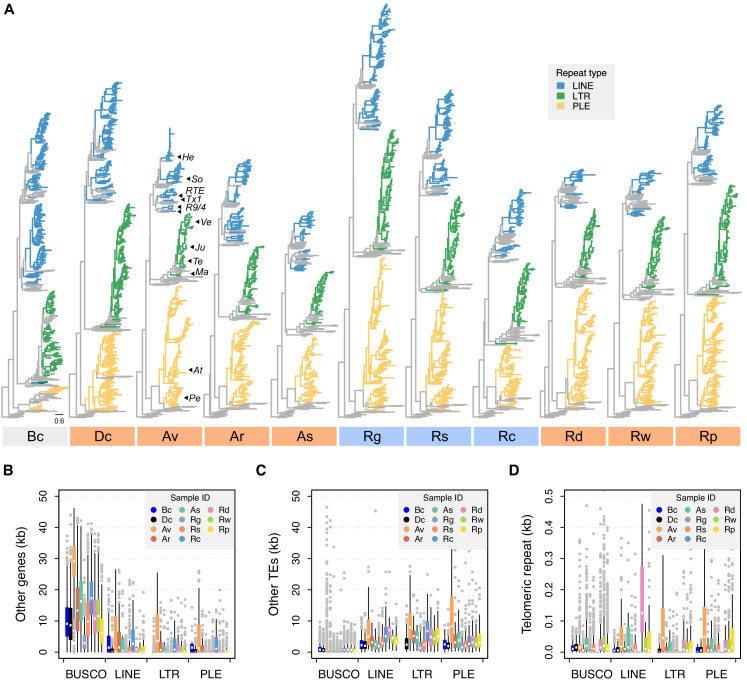
Phylogenetic diversity and genomic context of reverse transcriptase (RT) genes.(A) For each phylogeny, coloured branches represent identified rotifer-encoded RT copies and grey branches represent the core RT sequences from which the hidden Markov model (HMM) was built (see Figure 5—figure supplement 1 for core RT tree details). Colours indicate the major superfamilies. Previously characterized retrotransposons are indicated on the A. vaga tree (He, Hebe; So, Soliton; RTE, RTE; Tx1, Tx1; R9/4, R9 and R4; Ve, Vesta; Ju, Juno; Te, TelKA; Ma, Mag; At, Athena; Pe, Penelope). All phylogenies are rooted on the branch separating the bacterial retrons. Scale bar represents 0.6 amino acid substitutions per site. Desiccating and nondesiccating species are indicated with orange and blue, as previously. Species codes: Bc, B. calyciflorus PSC1; Dc, D. carnosus DCAR706, Av, A. vaga Av2013; Ar, A. ricciae ARIC003; As, A. steineri ASTE805; Rg, R. magnacalcarata MAG3; Rs, R. socialis AK11; Rc, R. macrura Rc2018; Rd, R. sordida RSOR408; Rw, R. sp. ‘Silwood-1’ RSIL806; Rp, R. sp. ‘Silwood-2’ RPSE503. The genomic context in which RT genes reside is then described based on proximity to three other features: (B) other genes (that do not overlap with any TE annotation), (C) other TEs, and (D) telomeric repeats (‘TGTGGG’; that do not overlap with any coding region) as identified in A. vaga. For each plot, a 50 kb window is drawn around the focal TE and the total span (kb) of each feature within the window is counted, broken down per sample ID (coloured boxes, see legend) per TE superfamily (X-axis groups). Boxplots show the median (band), interquartile range (box) and minimum/maximum values (whiskers; outliers are shown in grey). The equivalent data for BUSCO genes (metazoan set) are also shown for comparison. The same set of individuals are shown in (B–D) as for (A). Average values (mean ± SD) across monogononts and bdelloids (desiccating and nondesiccating) are provided in Figure 5—source data 4.Figure 5—source data 1.Reverse-transcriptase alignments and phylogenies.Figure 5—source data 2.Identification of putative telomeric repeats in rotifer genomes.Figure 5—source data 3.Posterior mean and 95% credible intervals for the effects of asexuality and desiccation ability on the density of three features (other genes, other TEs and telomeric repeats) surrounding LINE, LTR, and PLE class I TEs, compared to BUSCO genes.Figure 5—source data 4.Mean and standard deviation (SD) for the span (kb) of features ‘other genes’, ‘other TEs’ and ‘telomeric repeats’ occurring in 50 kb windows around genes of type BUSCO, LINE, LTR, or PLE, averaged across monogononts versus bdelloids and desiccating versus nondesiccating bdelloids.